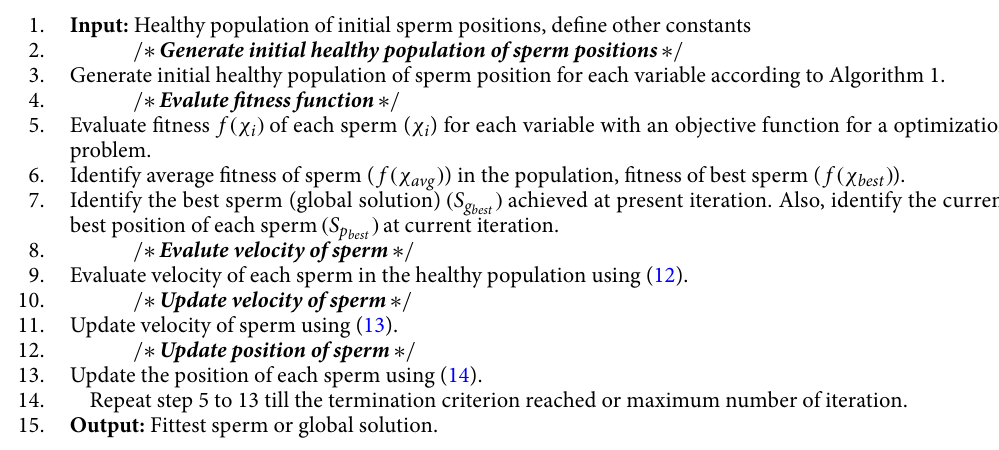
Algorithm 2: Pseudo-code of HCO for update sperm